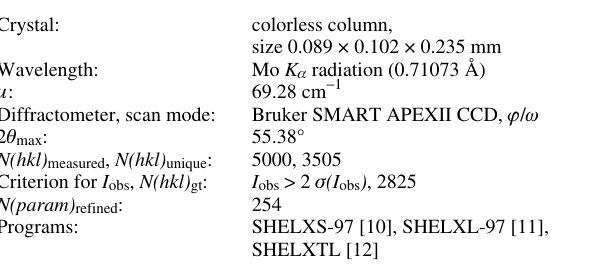
Table 1. Data collection and handling.